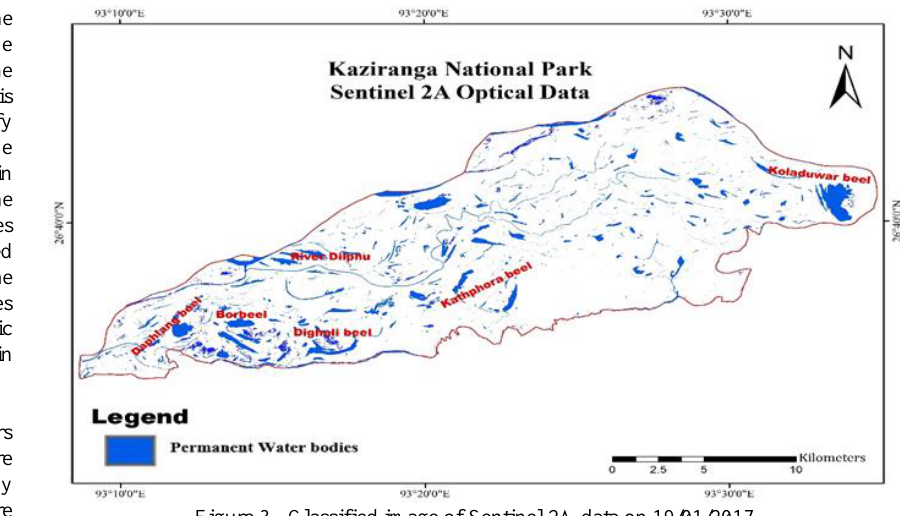
Figure 3. Classified image of Sentinel 2A data on